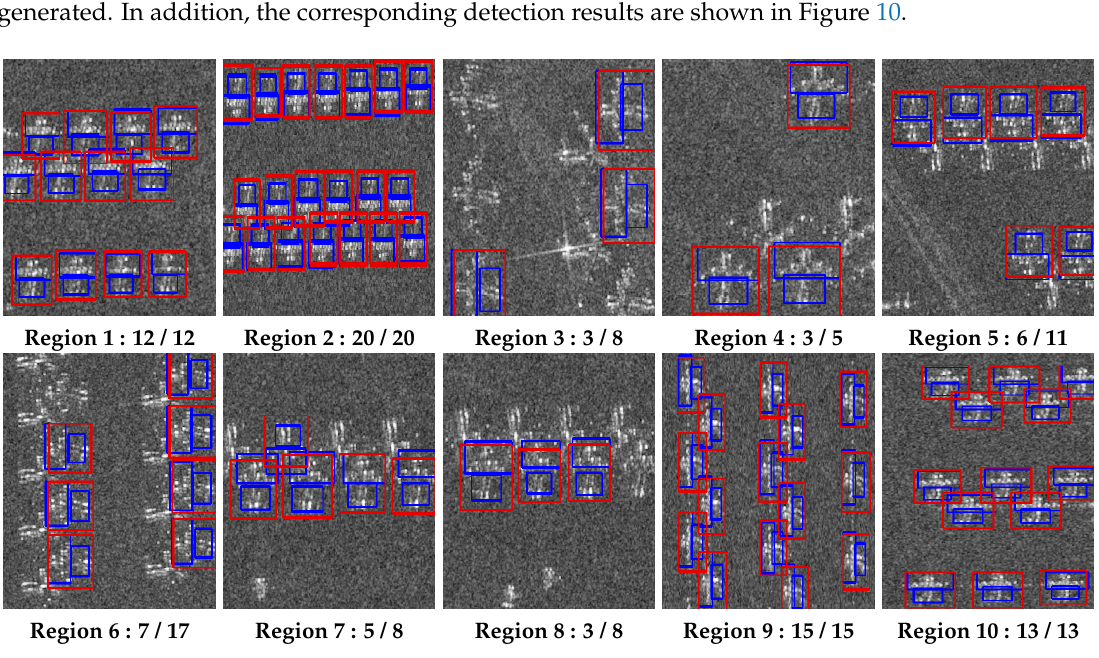
Figure 10. Detection results of the newly trained model. (For a/b after each region, a represents number of the correctly detected airplanes; b is the number of total aircrafts in the